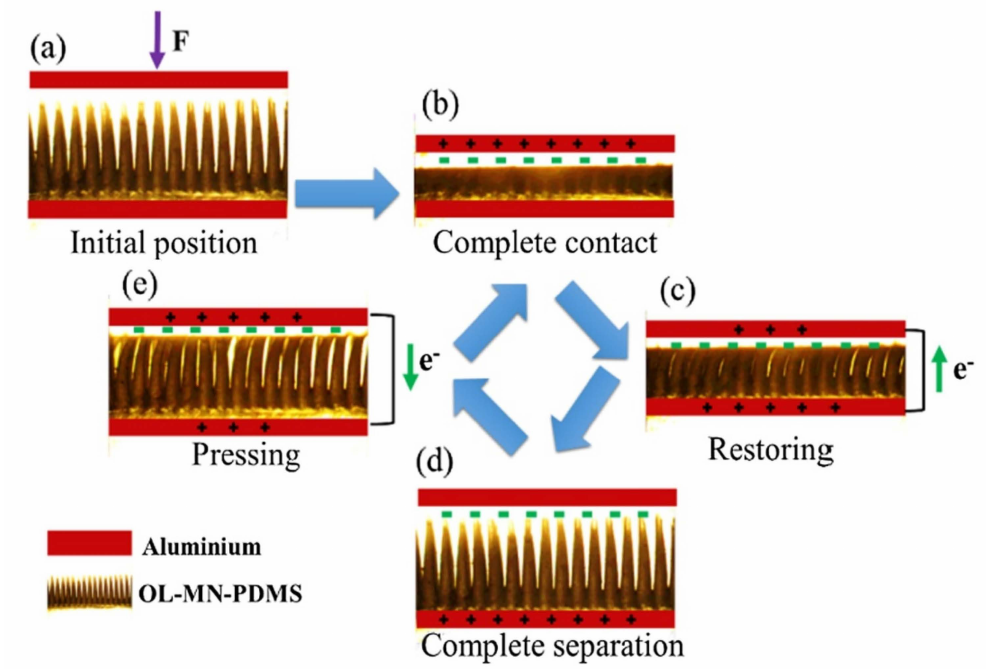
Figure 28. The basic operating mechanism of the overlapped microneedle (OL-MN)-TENG: ( a ) Initial position, ( b , c ) complete contact and restoring with reducing force and ( d , e ) complete separation and pressing with increasing force. Then cycling operation through ( b – e